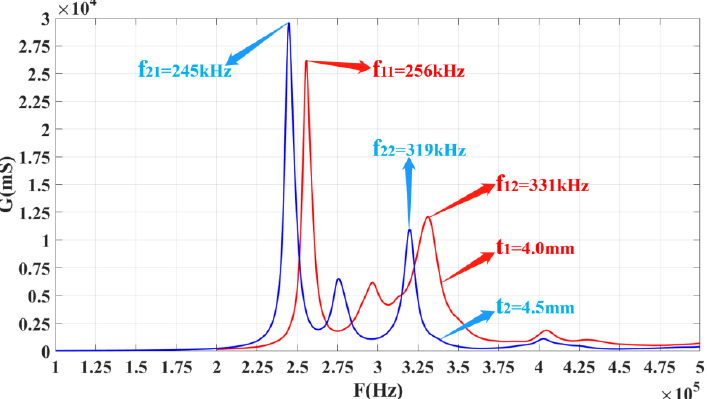
Figure 9. Conductance curves of every single ring of the stacked sensitive element.